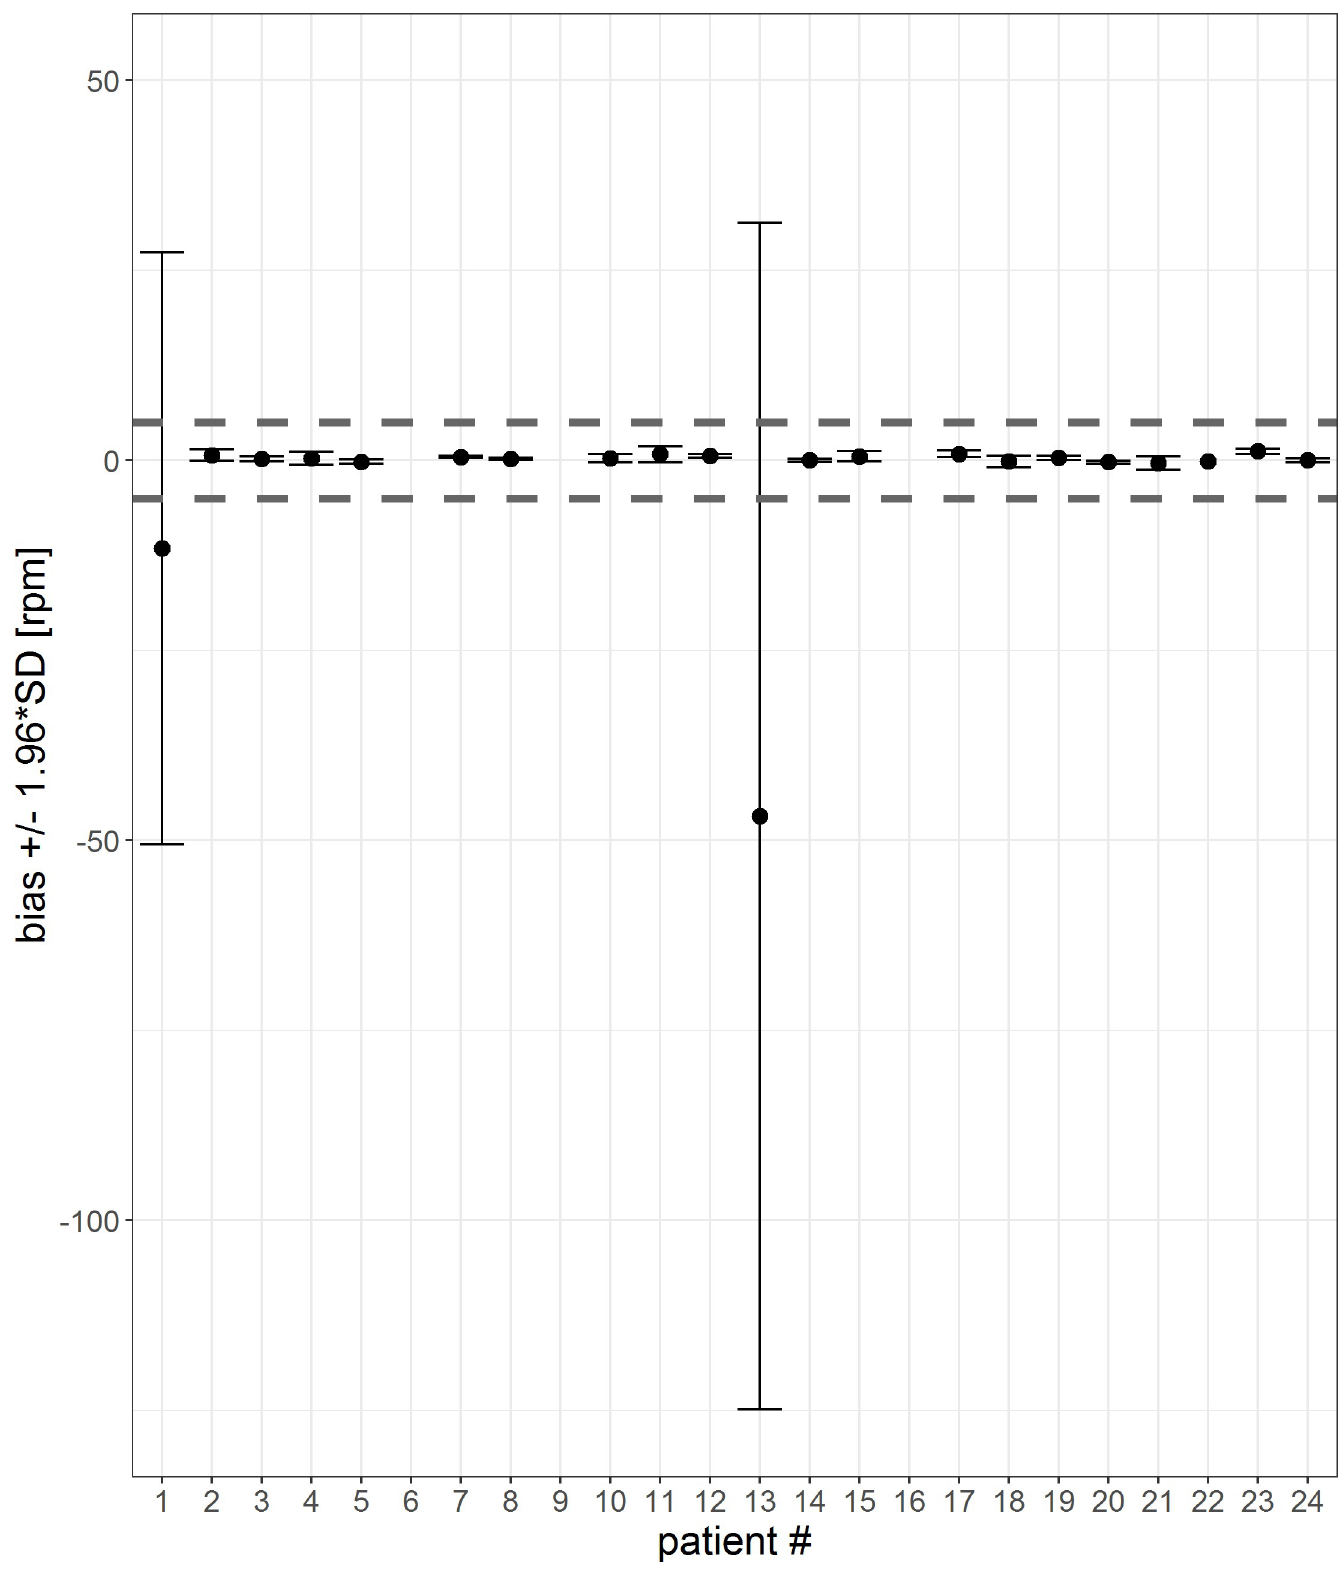
Fig 7. Error bar of each patient for a 5-min-interval. The mean differences and confidence interval (bias +/- 1.96 � SD) for each patient are plotted. Difference was calculated by subtracting patient monitor data from Healthdot data, based on 5-min averages. The gray dashed lines indicate the required threshold of 5 bpm. https://doi.org/10.1371/journal.pone.0247903.g007 PLOS ONE | https://doi.org/10.1371/journal.pone.0247903 April 28,